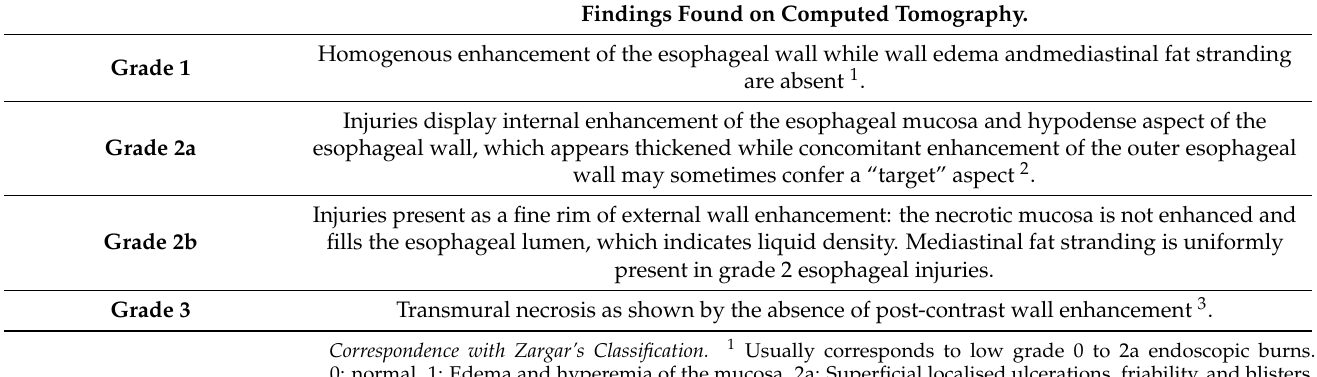
Table 4. Classification of the severity of lesions according to computed tomography (CT) [88,92]. Findings Found on Computed